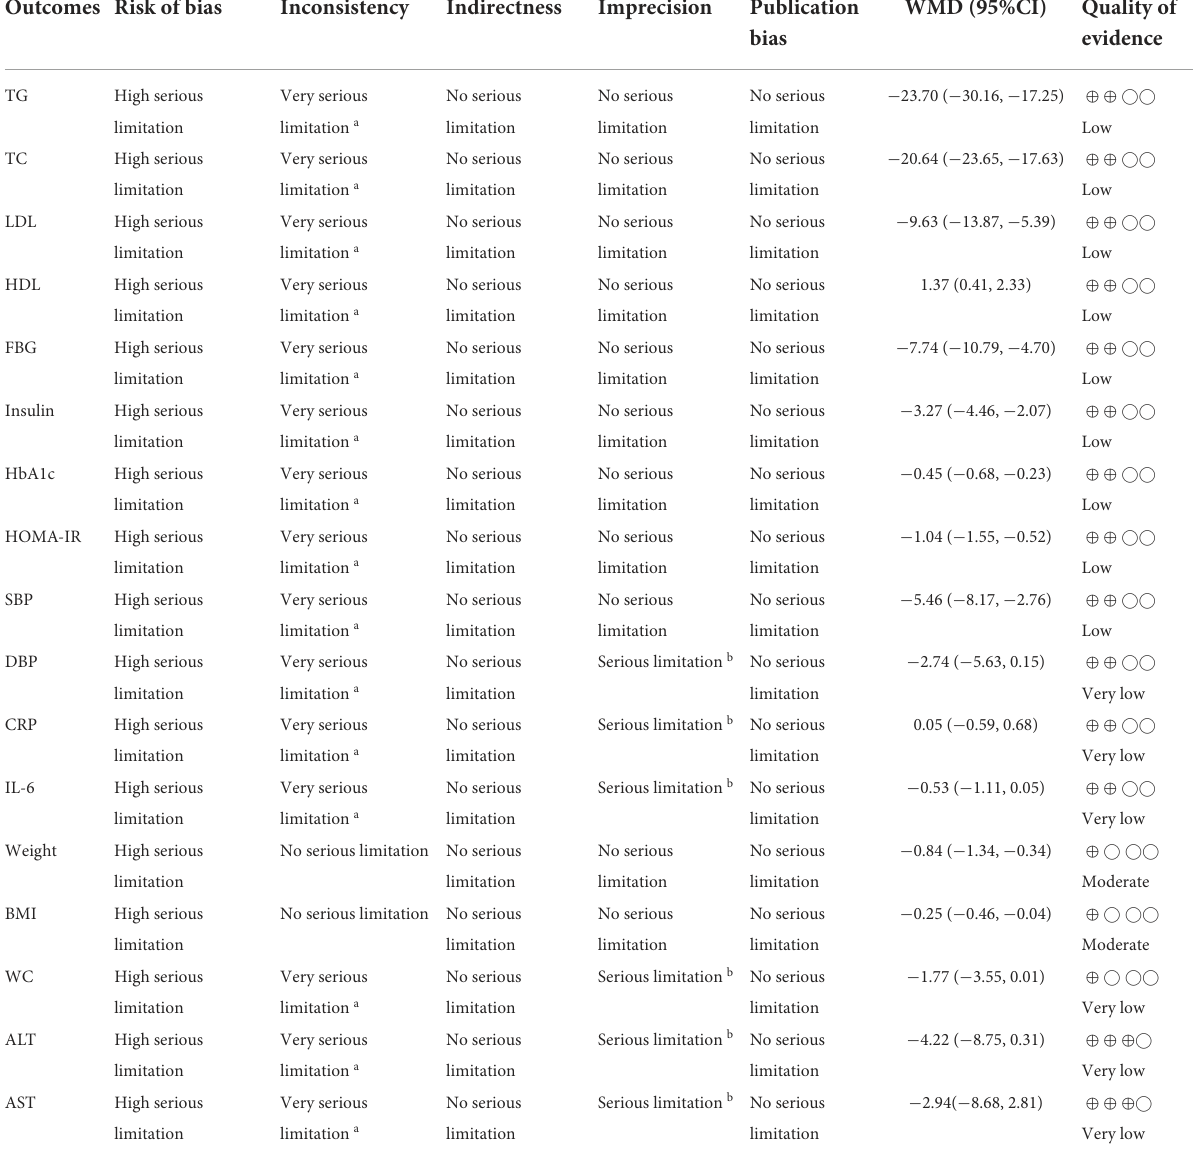
TABLE 4 GRADE profile of berberine supplementation on cardiovascular risk factors in adults. Outcomes Risk of